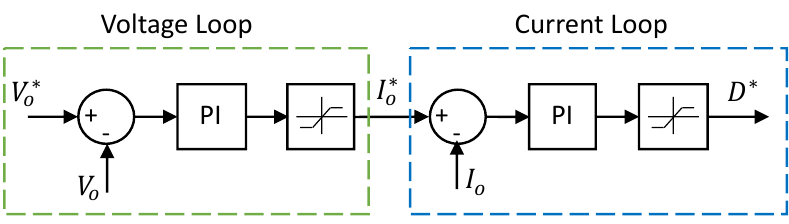
Figure 5. Closed − loop control scheme for CC/CV charging